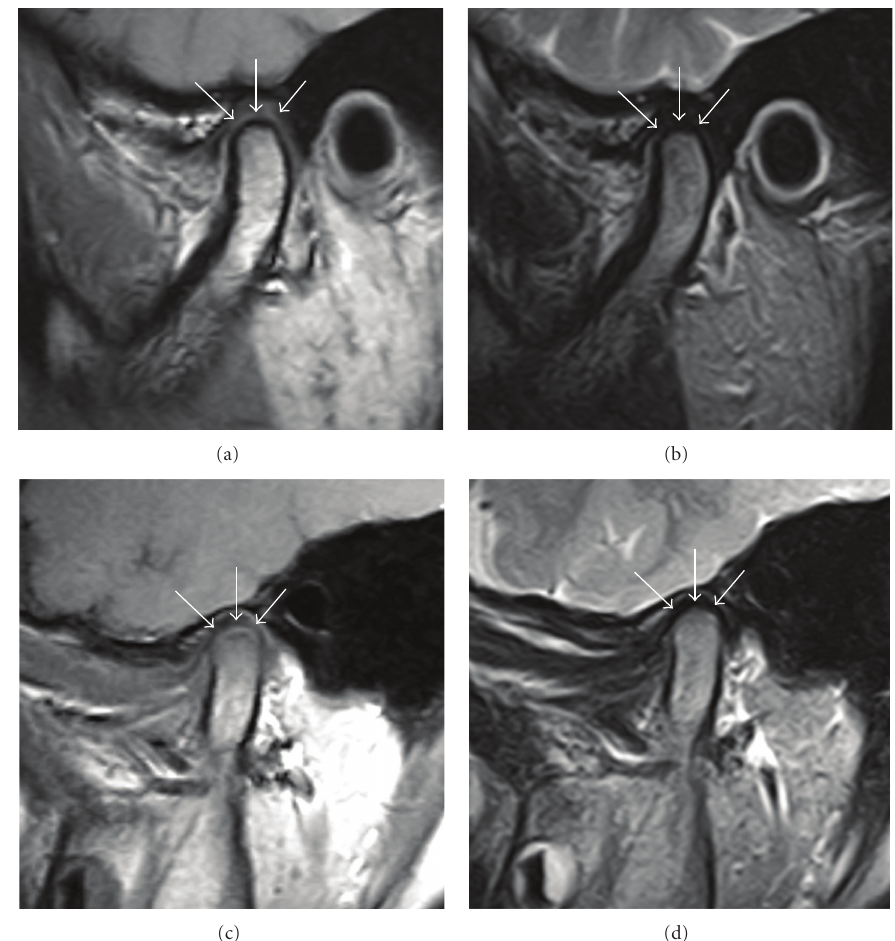
Figure 1: Di ff erences in TMJ between normal adults (a, b) and schoolchildren (c, d) on MRI. (a) DCLS on the top of the mandibular condyles was undetectable (arrows) on fast spin-echo intermediate-weighted images of a healthy 34-year-old female. The voided signal line at the top of the right mandibular condyle was seen as a successive continuity. The imaging parameters used in the MR sequences included 1050 ms TR, 15 ms e ff ective echo time, flip angle of 90 ◦ , a 15 × 15 cm field of view, a matrix of 160 × 288 pixels, 17 mm slab thickness, and 3 mm section thickness. (b) High-intensity stripes on the top of the mandibular condyles were undetectable (arrows) on fast spin-echo T2-weighted images of the same subject as Figure 1(a). The imaging parameters used in the MR sequences included 3500 ms TR, 108 ms e ff ective echo time, flip angle of 90 ◦ , a 15 × 15 cm field of view, a matrix of 160 × 288 pixels, 17 mm slab thickness, and 3mm section thickness. (c) DCLS on the top of the mandibular condyles (arrows) appeared as high-intensity stripes over a low-intensity area on fast spin-echo intermediate-weighted images of a healthy 8-year-old boy. The voided signal line at the top of the right mandibular condyle was not seen. The imaging parameters used in the MR sequences included 1050 ms TR, 15 ms e ff ective echo time, flip angle of 90 ◦ , a 15 × 15cm field of view, a matrix of 160 × 288 pixels, 17mm slab thickness, and 3 mm section thickness. (d) High-intensity stripes (arrows) were found to coincide with DCLS on the top of the mandibular condyles; this was found using fast spin-echo T2-weighted images of the same subject as Figure 1(c). The imaging parameters used in the MR sequences included 3500 ms TR, 108ms e ff ective echo time, flip angle of 90 ◦ , a 15 × 15cm field of view, a matrix of 160 × 288 pixels, 17 mm slab thickness, and 3mm section